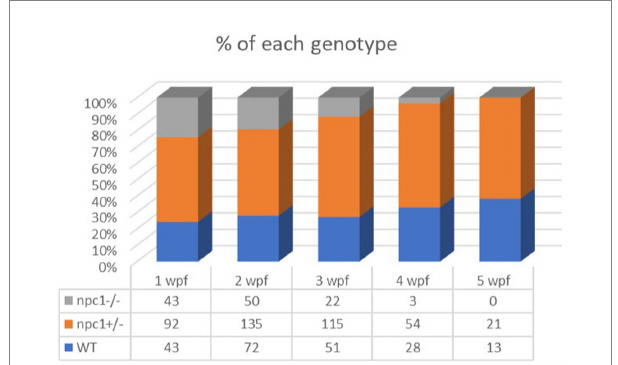
FIGURE 2 Representation of the percentage of surviving individuals per